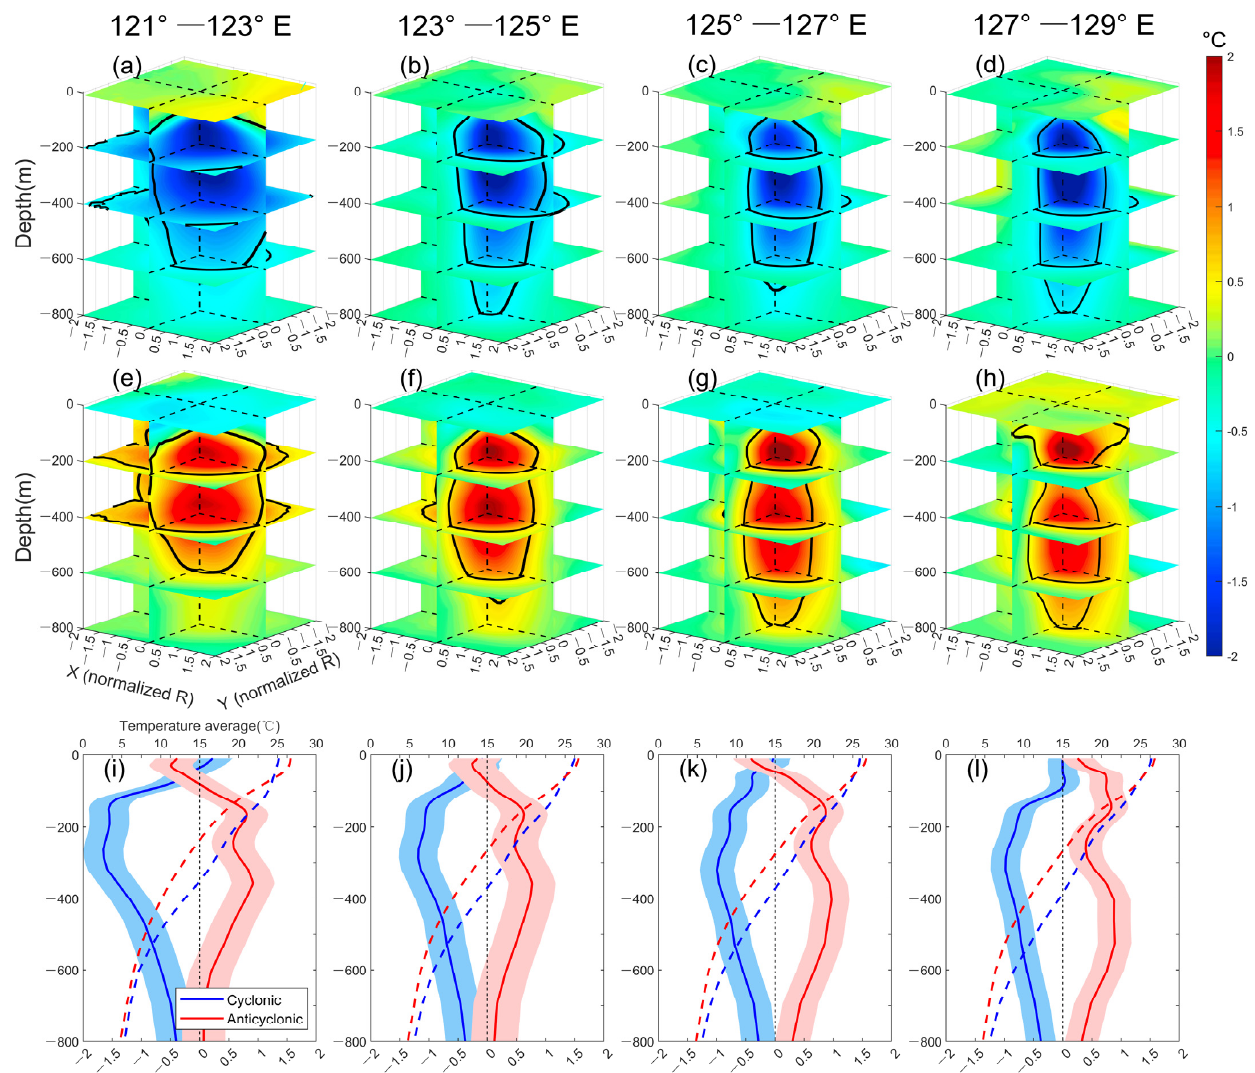
Figure 8. Temperature anomalies of composited cyclonic ( a – d ) and anticyclonic ( e – h ) eddies within different longitudinal bands. Black curves represent the boundaries of the eddy structure with 0.6° C temperature anomalies. X (Y) represents the normalized distance (evaluated by the eddy radius) in the zonal (meridional) direction. The vertical profiles of the averaged temperature (dashed curves) and its anomalies (solid curves) in each band are also shown ( i – l ). The shadows in ( i – l ) are standard deviations. Blue and red curves represent the cyclonic and anticyclonic eddies, respectively.